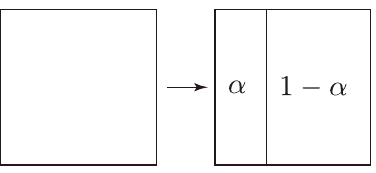
Figure 6. The fraction of a pixel after the partitioning process, represented by (cid:11)